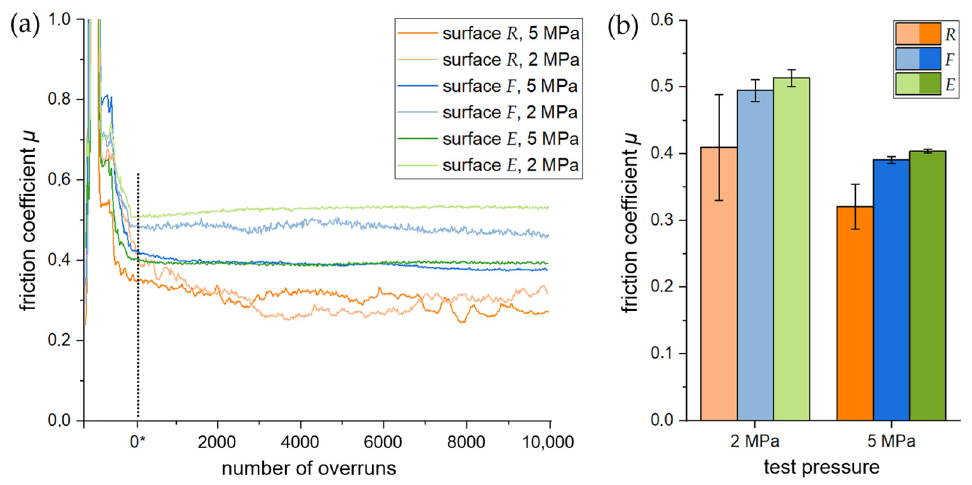
Figure 5. ( a ) Typical curves of the friction coefficient ( µ ) until 10,000 overruns (1500 m sliding distance) are shown for both test pressures and each surface condition. When preset test pressure is achieved (at 0* overruns), µ does not change longer. ( b ) It can be seen that HP (5 MPa) leads to a lower µ . While surfaces F and E show a similar behaviour, surface R is characterised by lower friction coefficients with higher standard deviations.